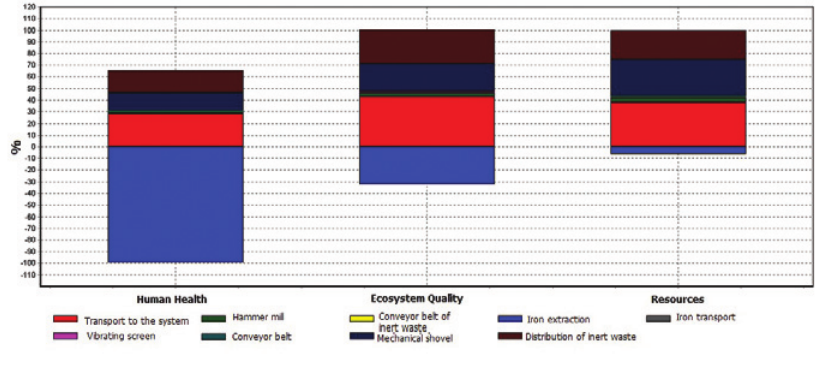
Fig. 12. Characterization of impacts generated by various processing phases involved in C&DW recycling/reuse, based on Eco-Indicator